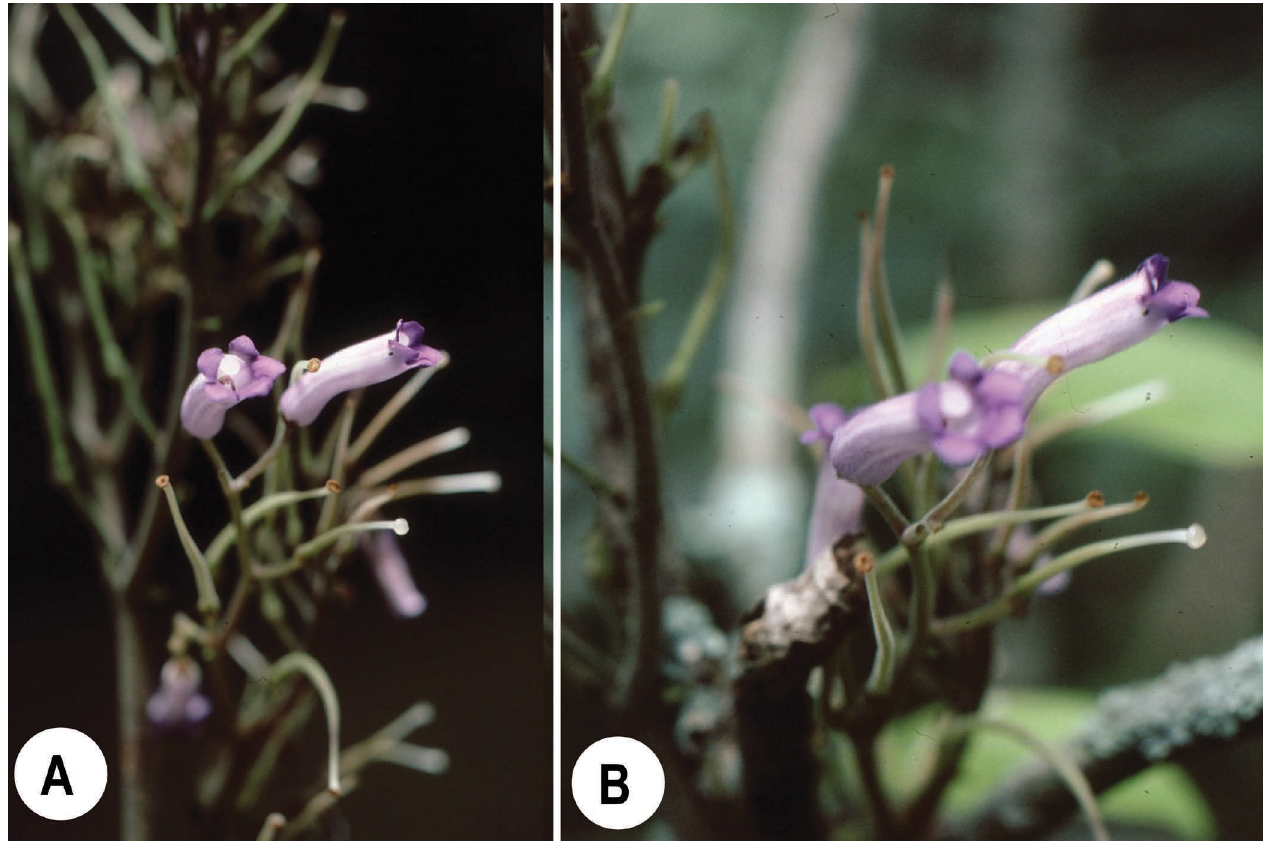
Figure 4 – Streptocarpus bampsii . A–B . Details of inflorescence. Photographs taken by Paul Bamps ( Bamps & Malaisse 8389 ). © Paul Bamps, all rights